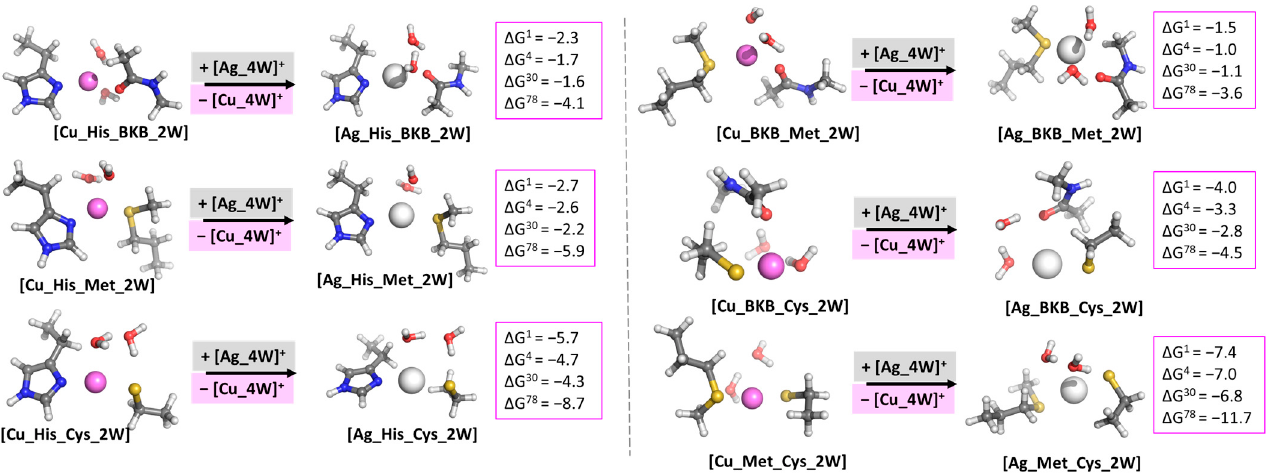
Figure 4. Gibbs energies of Ag + → Cu + substitution given in kcal mol − 1 in four different environments (denoted as ∆ G 1/4/30/78 ) for M062X/6-311++G(d,p)/SDD-optimized [M_AAM 1 _AAM 2 _2W] structures. The applied color scheme has been previously presented in Figure 3.